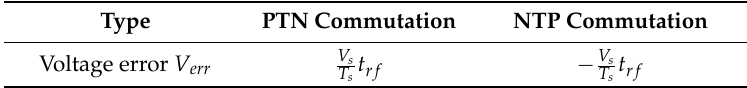
Table 1. The average voltage errors of PTN and NTP commutations.